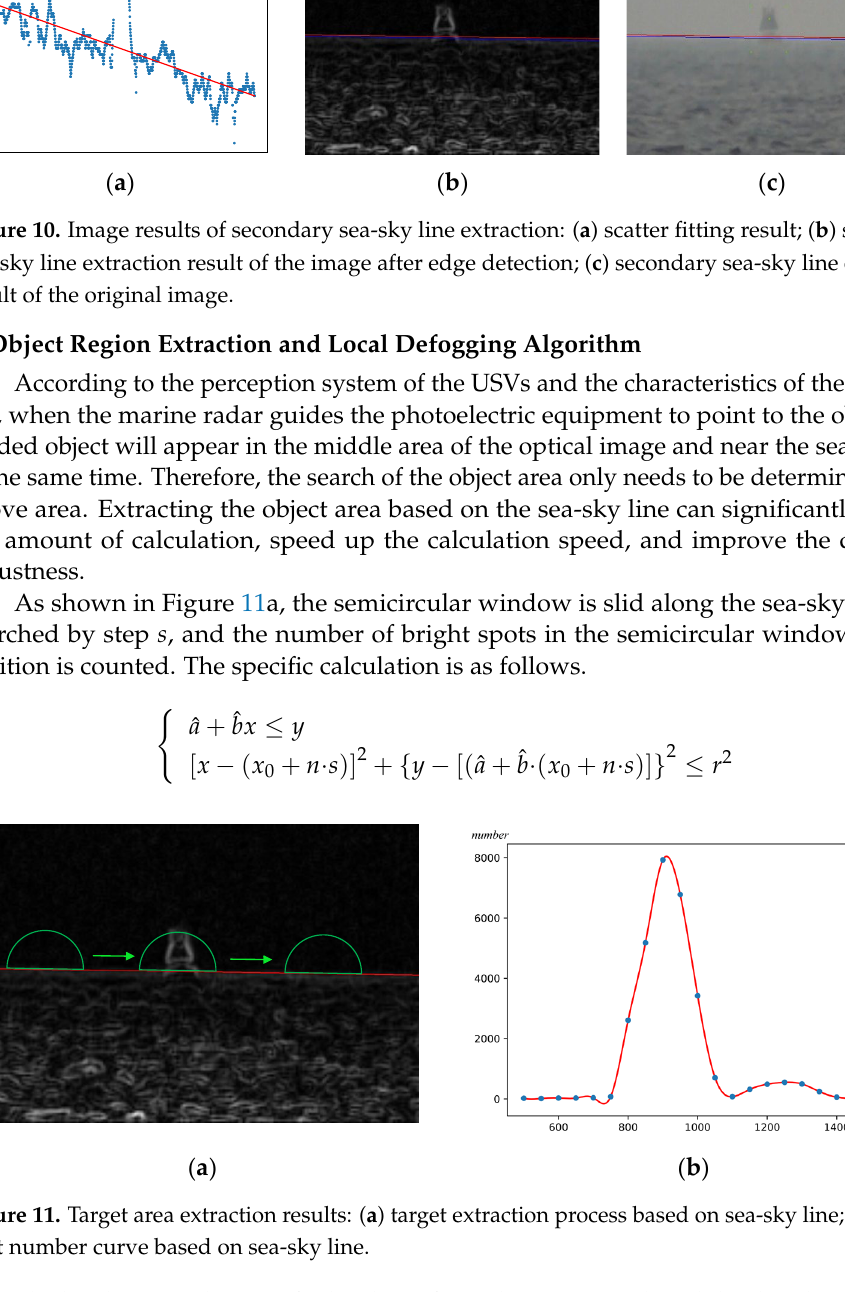
bright spot number curve based on sea-sky line. spot number curve based on sea-sky